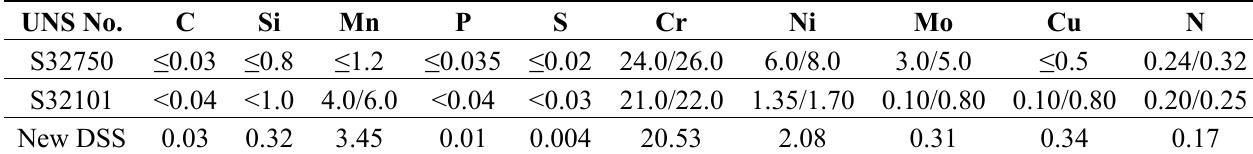
Table 1. Chemical composition (wt%) of the duplex stainless steels (DSS).